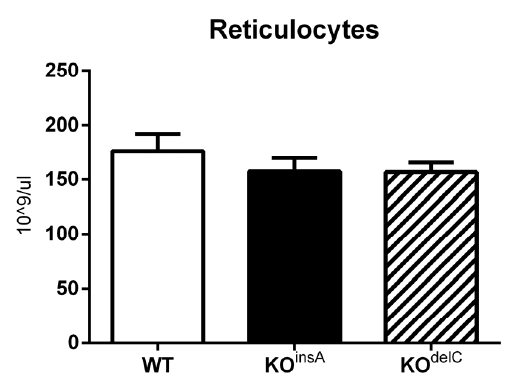
Figure 3. Reticulocyte levels of TAAR9-KO and WT rats. There are minor trends detected in reticulocyte cell concentration in TAAR9-KO strains in comparison to WT rats, n = 7 per group. Data are mean ± SEM.